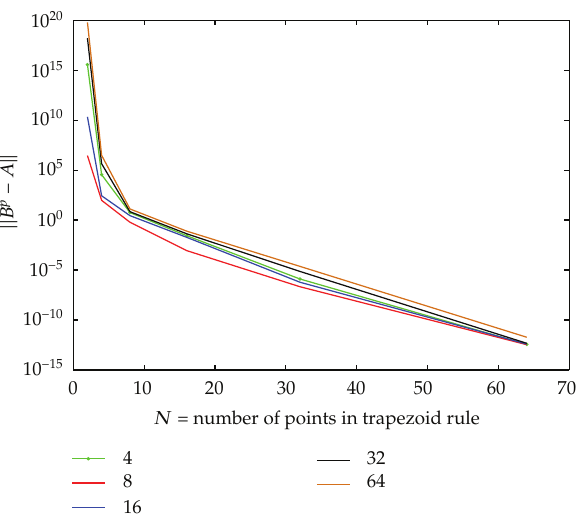
Figure 1: Error in trapezoid rule for computing A 1 /p as matrix size